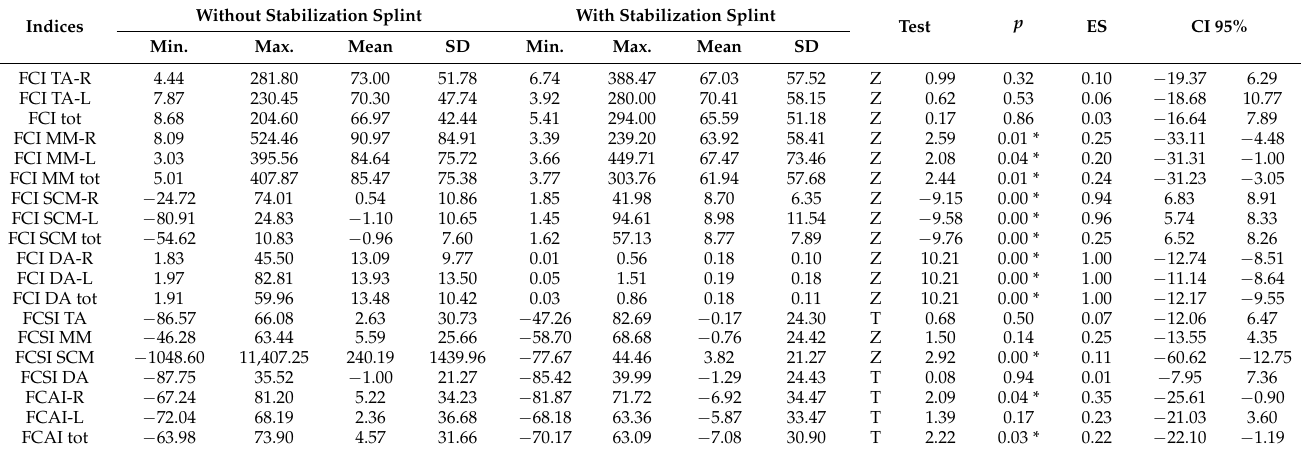
Table 4. Comparison of functional indices with and without stabilization splint.